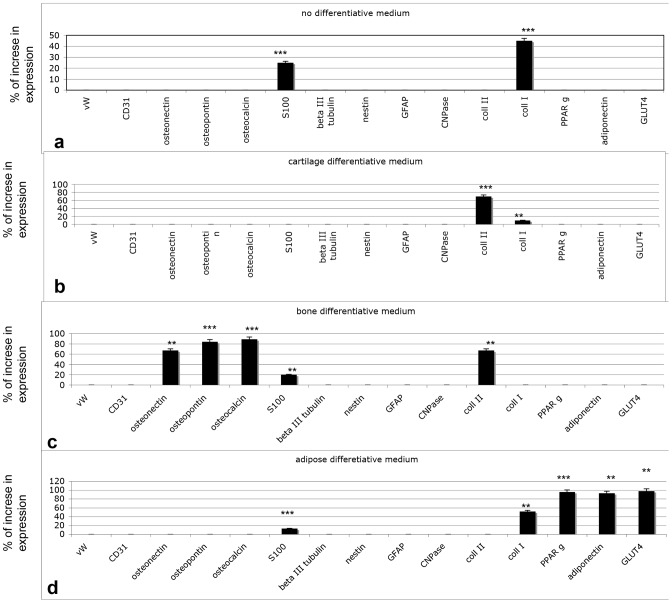
Gene expression according to real-time PCR on undifferentiated DPSCs in basal culture medium (A) and in media that induce differentiation: chondrogenic (B), osteogenic (C) or adipogenic (D).One-way analysis of variance (ANOVA) was used for data analyses. The Leveneís test was used to demonstrate the equal variances of the variables. Repeated-measures ANOVA with a post-hoc analysis using Bonferroni's multiple comparison. T tests were used to determine significant differences (p<0.05). * p<0,05; * * p<0,01; * * * p<0,001. Repeatability was calculated as the standard deviation of the difference between measurements.